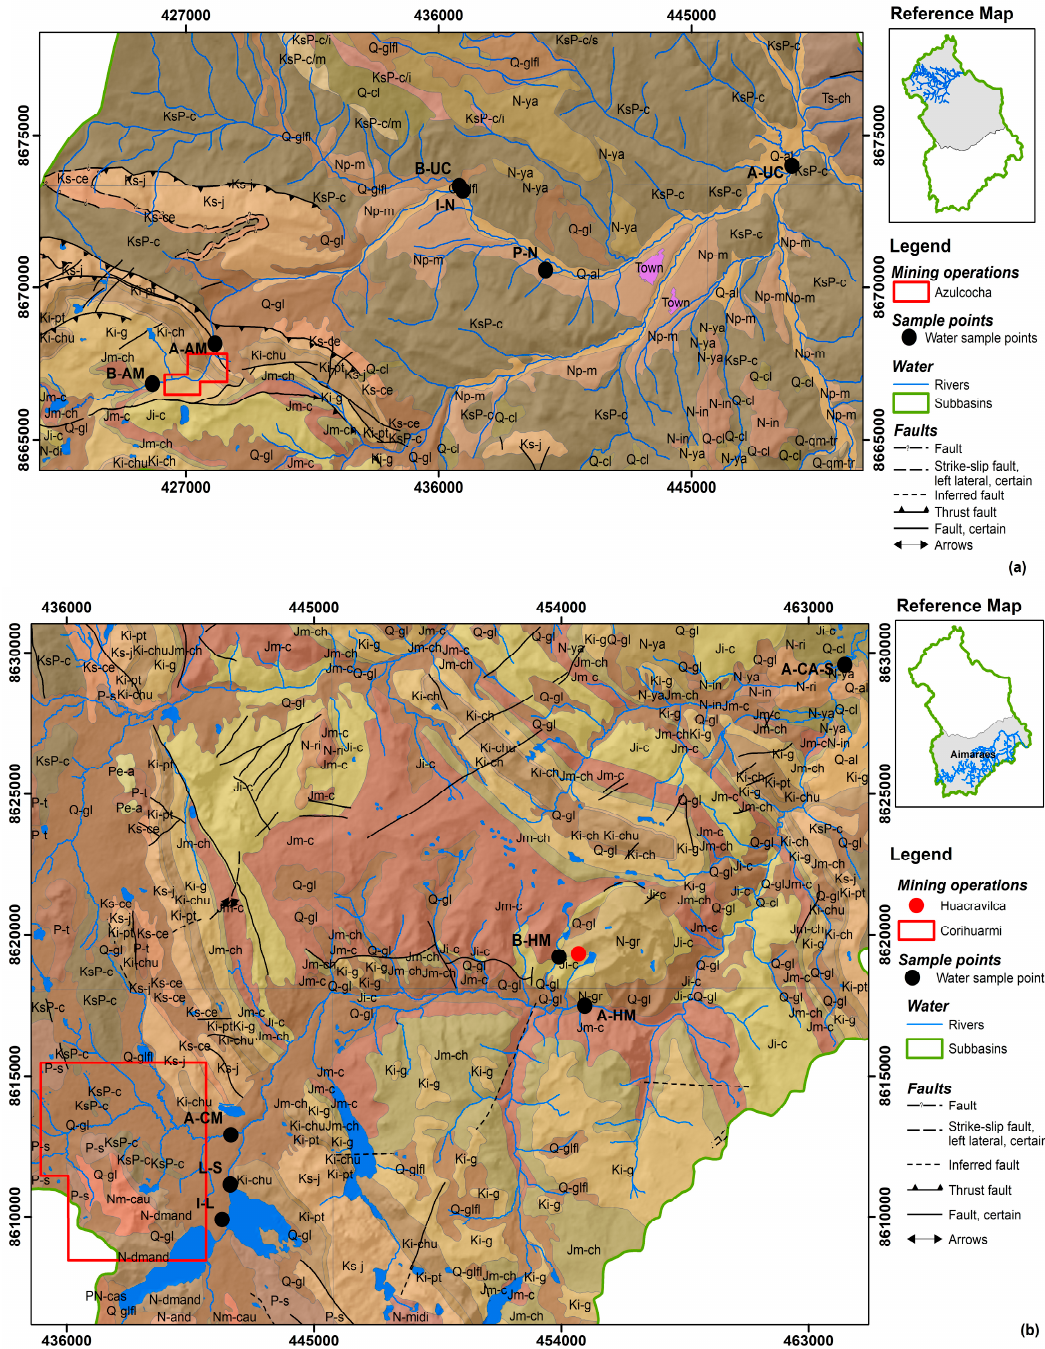
Figure 3. Water sample points and geology in ( a ) Cunas and ( b ) Aimaraes sub-basins; based on Geological, Mining and Metallurgical Institute (INGEMMET) [73]. Geological, Mining and Metallurgical Institute (INGEMMET)